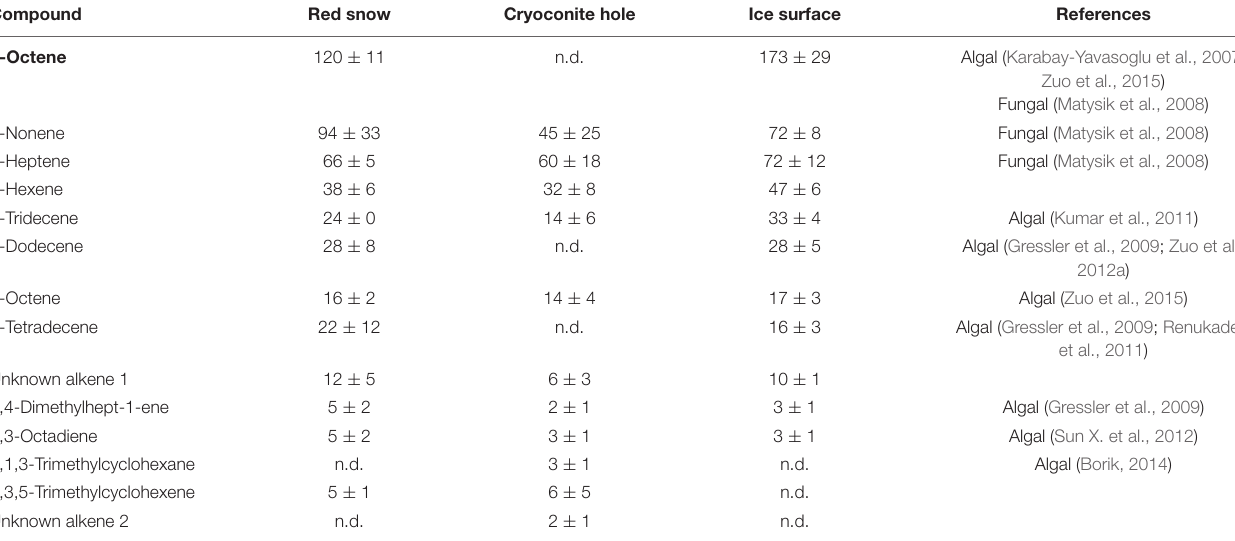
TABLE 4 | Mean (ng m − 2 h − 1 ± SE) alkene emissions measured in three microbiological habitats on the southern Greenland ice sheet. Compound Red snow Cryoconite hole Ice surface